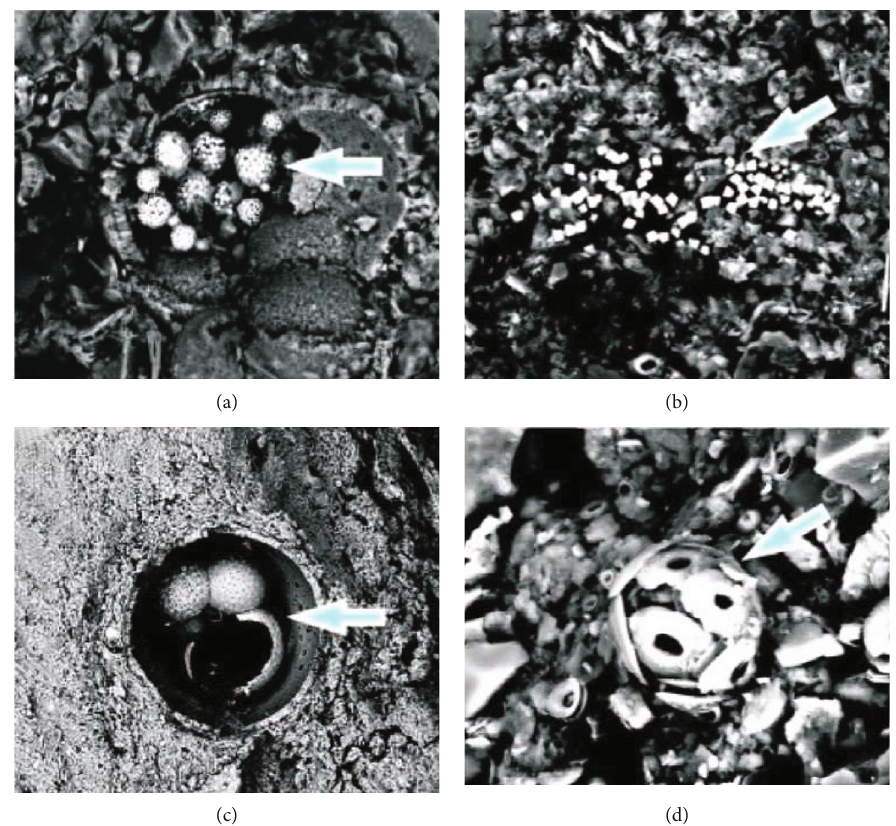
Figure 7: The scanning electron micrograph of W19 well in Shenhu: (a) strawberry pyrite; (b) dispersed particles; (c) foraminifera; (d) coccolith